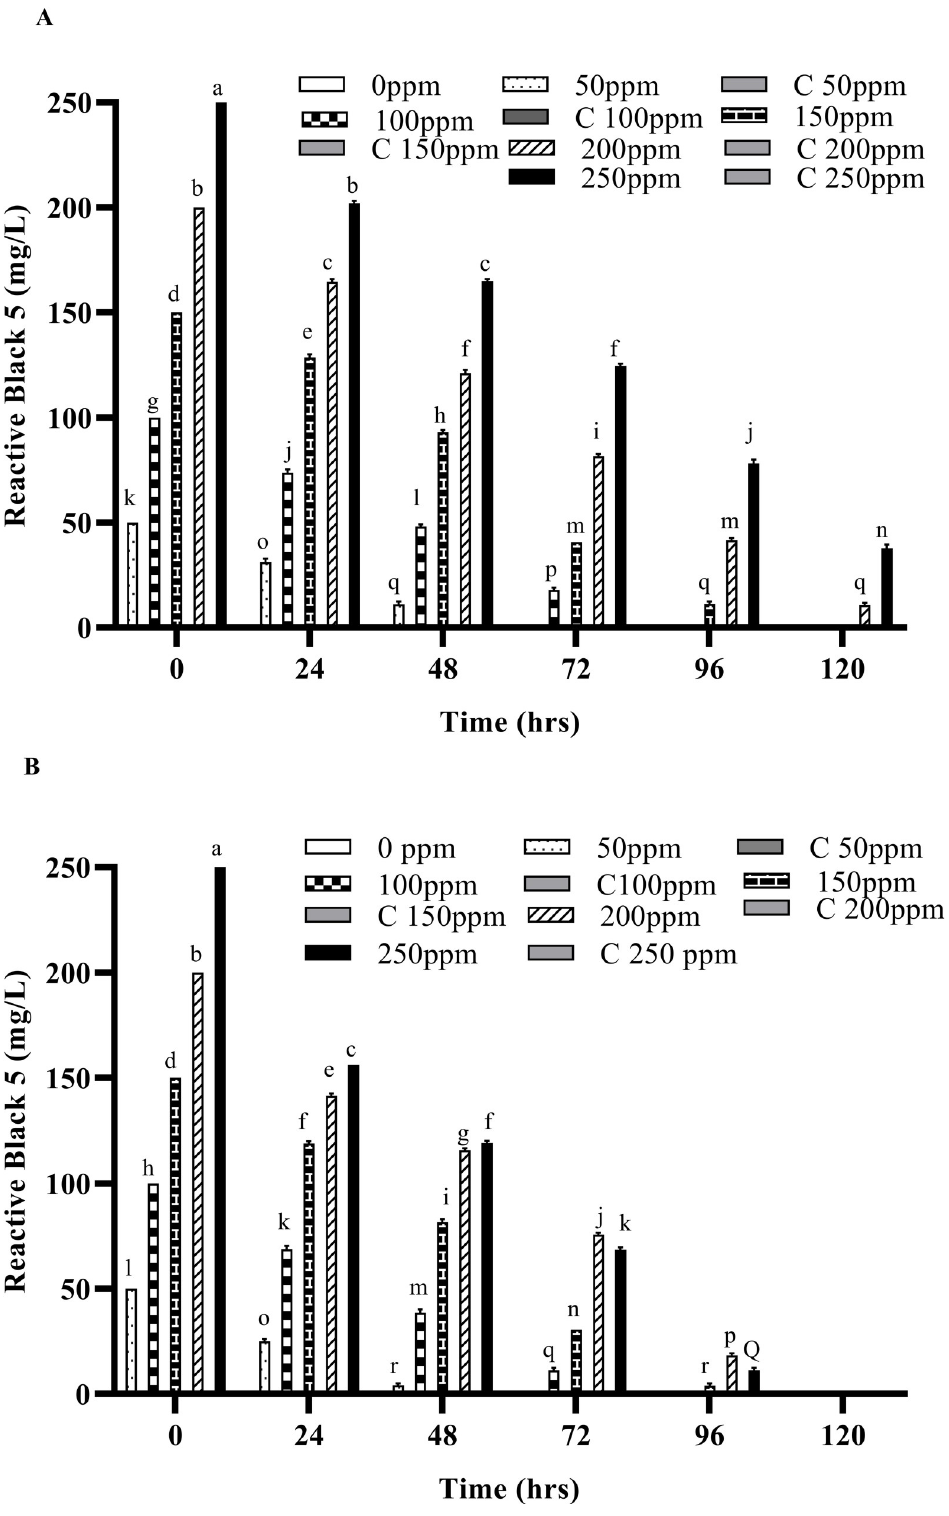
Fig 5. Concentrations of Reactive black 5 degraded after treatment with free and immobilized cells of the bacterial strain (A) Degraded by free cells at 37 ˚C (B) Degraded by immobilized cells at 37 ˚C Different alphabets show the significant differences (p < 0.05) between different